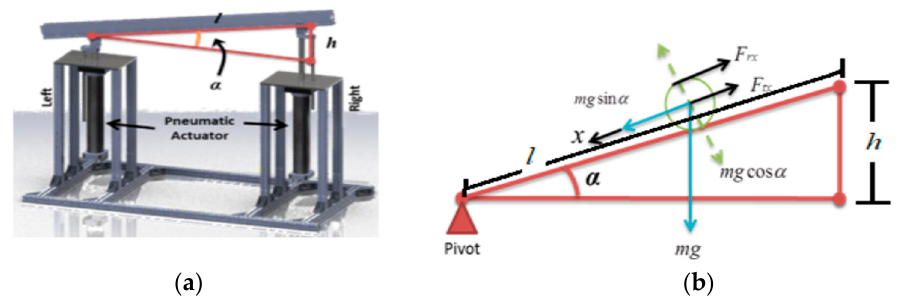
Figure 6. ( a ) IPABB system ( b ) Free body diagram.